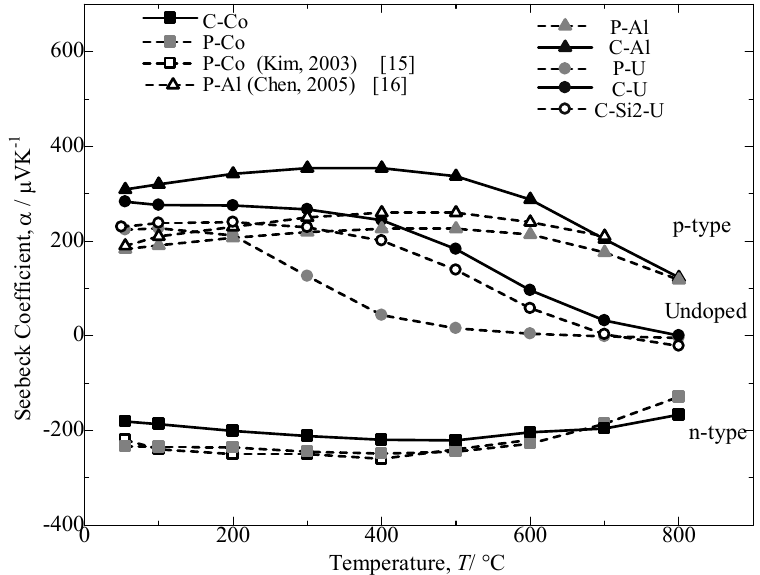
Figure 7. Temperature dependence of Seebeck coefficient, α , for the annealed β -FeSi samples at 900 °C for 5